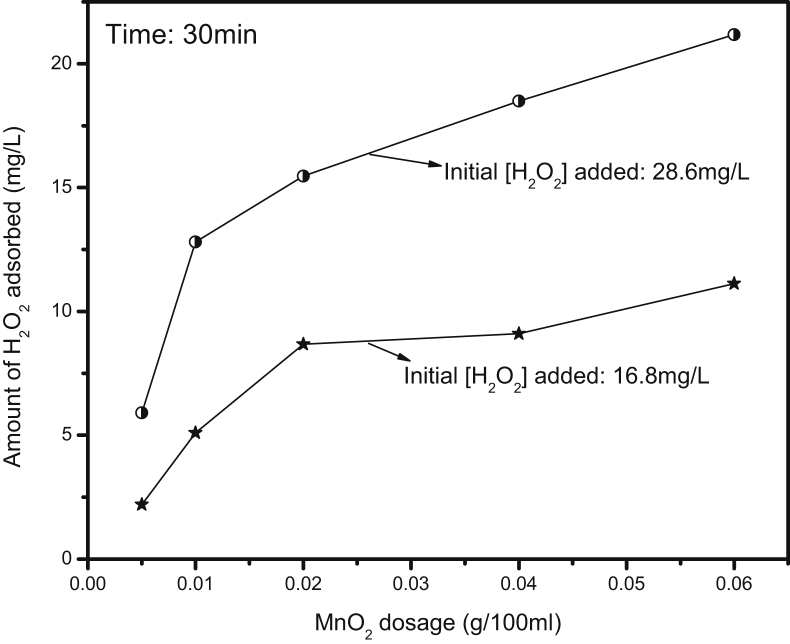
Effect of MnO2 dosage on the adsorption/decomposition of H2O2.